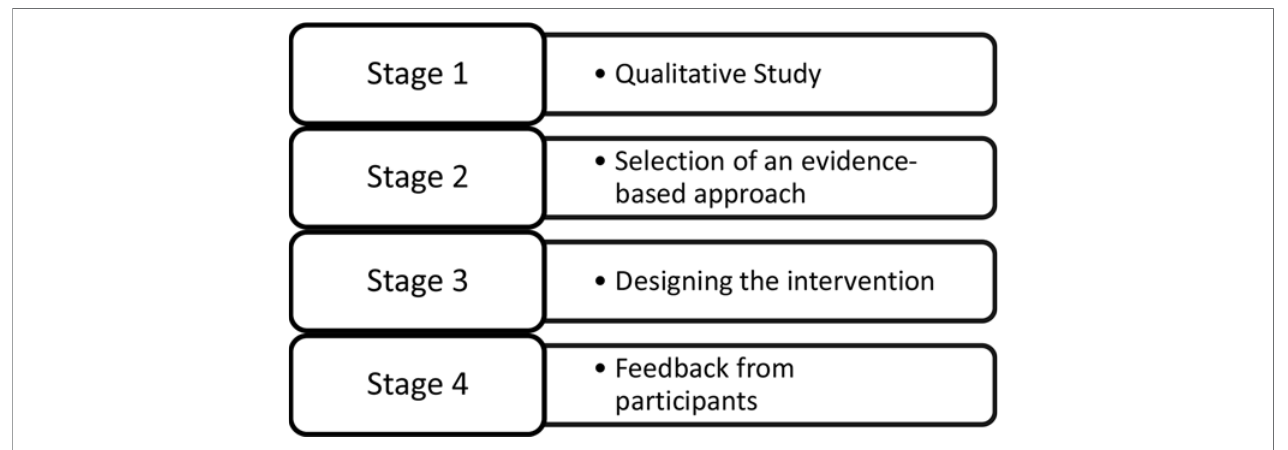
FIGURE 1 | Process of intervention development.